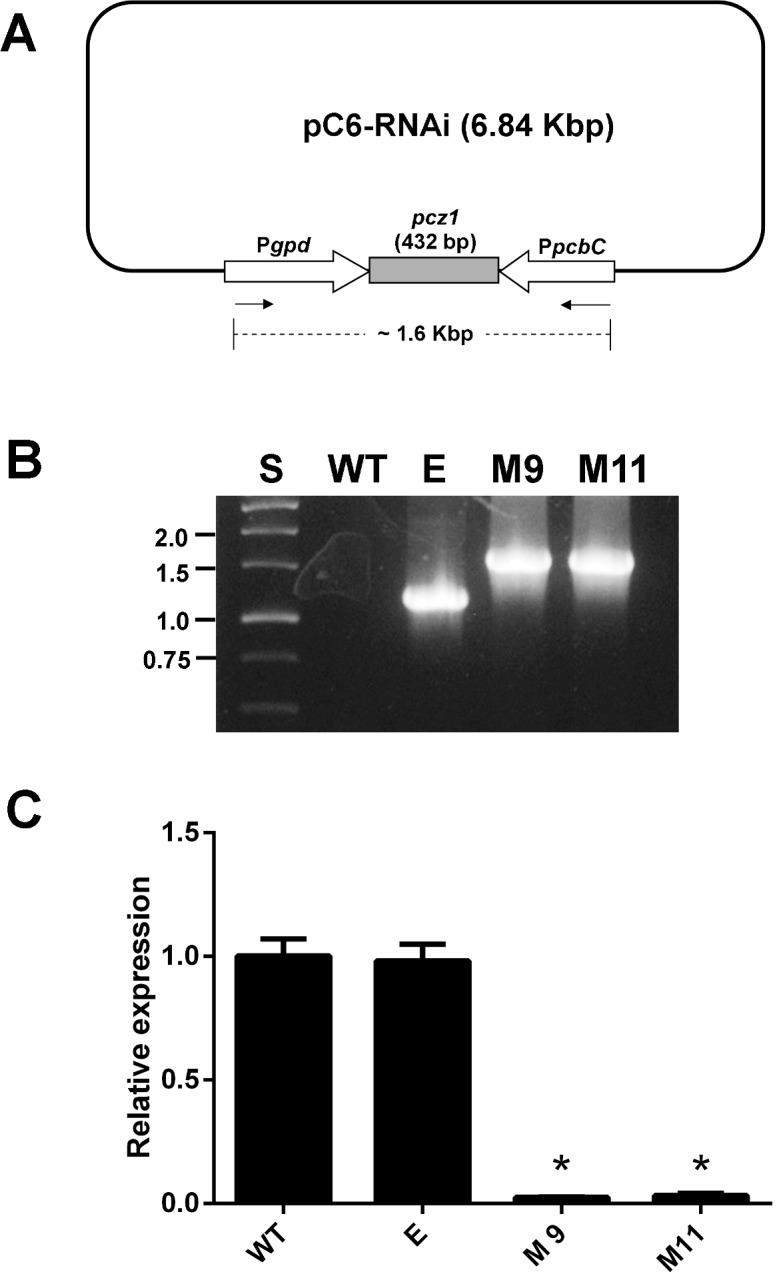
Gene silencing of pcz1 in P. roqueforti.(A) Schematic representation of the full silencing cassette in plasmid pC6-RNAi. Pgpd and PpcbC represent the convergent promoters from the gpd gene from A. nidulans and the pcbC gene from P. chrysogenum [14]. The small black arrows represent primers ConfRNAiFW (5`- GCATGCCATTAACCTAGG-3`) and ConfRNAiRV (5`-ACGGTGGCTGAAGATTC-3`), which were used to confirm the integration of the full silencing cassette (see panel B). The expected size of the amplicon containing the full silencing cassette is shown. For simplicity, other elements from the plasmid, such as phleomycin and ampicillin resistance genes and the bacterial replication origin, were omitted. The drawing is not to scale. (B) PCR assay demonstrating integration of the full silencing cassette in transformants M9 and M11 transformed with pC6-RNAi. PCR products were subjected to electrophoresis in agarose gels. Lane WT: wild type strain P. roqueforti CECT 2905; lane E: P. roqueforti CECT 2905 containing empty pJL43-RNAi vector; lane S: Standard GeneRuler 1 kb DNA Ladder (Fermentas). Relevant sizes expressed in kb are shown at left. (C) qRT-PCR analysis of the expression of pcz1 in P. roqueforti CECT 2905 (WT), P. roqueforti CECT 2905 containing empty pJL43-RNAi vector (E) and RNAi-silenced transformants M9 and M11. RNA was extracted from strains grown 5 days in YES medium. See Materials and Methods for other details. Error bars represent the standard deviation of three replicates in three different experiments. The differences were considered statistically significant at P < 0.05 (*) by using the Student’s t-test.